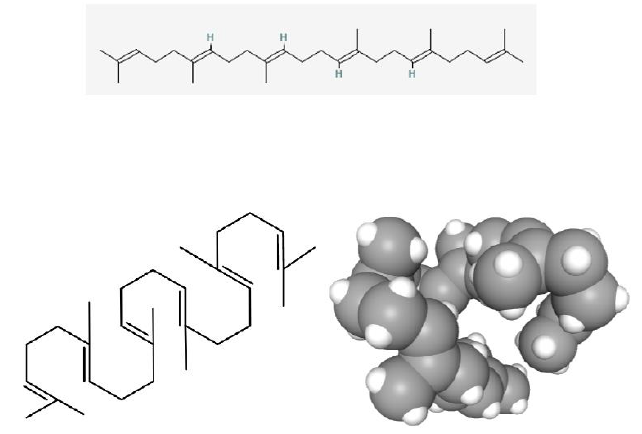
Figure 1. Squalene chemical structures. Obtained from https://pubchem.ncbi.nlm.nih.gov/ compound/638072#section=2D-Structure, accessed on 9 February 2022 and https://www.lipidmaps. org/databases/lmsd/LMPR0106010002?LMID=LMPR0106010002, accessed on 9 February 2022.